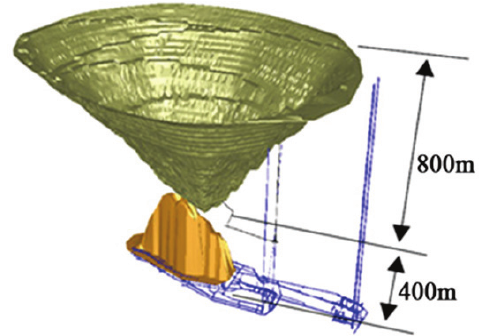
Fig. 3. Three-dimensional model of pit and cave at Palabora mine (Brummer et al. [3])